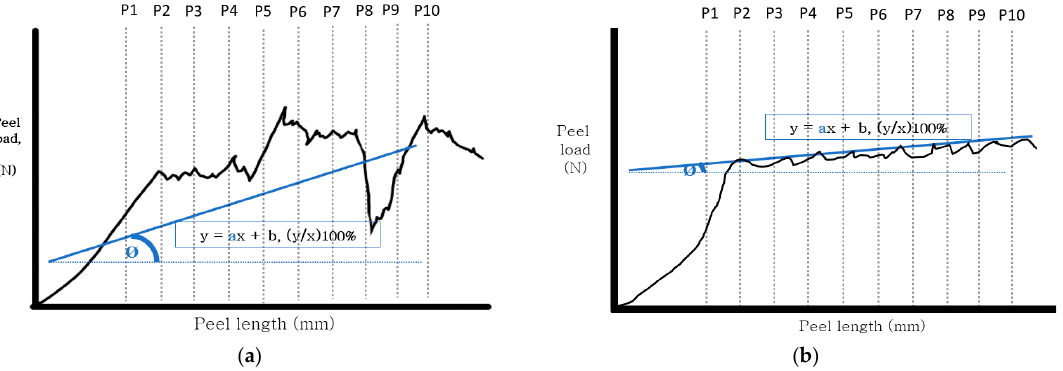
Figure 10. A stability analysis comparison example of peel load data regression line grade; ( a ) case with high regression line grade, ( b ) case with low regression line grade.